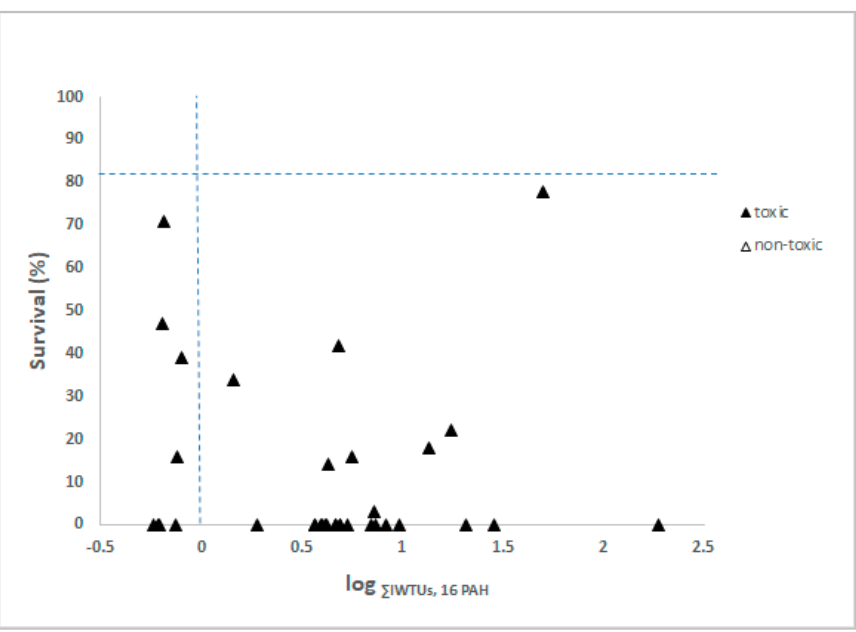
Figure 10. Diagram of the correlation of interstitial water toxic units and zebrafish embryo survival